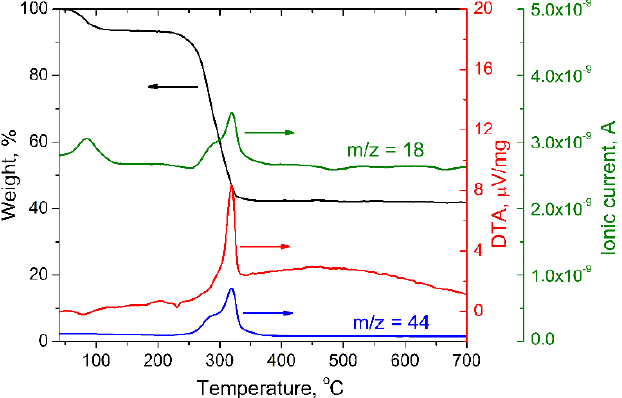
Figure 1. Thermal analysis results and MS-signal for mass number 44 (CO 2 ) and 18 (H 2 O) for freeze dried acetate mixture.